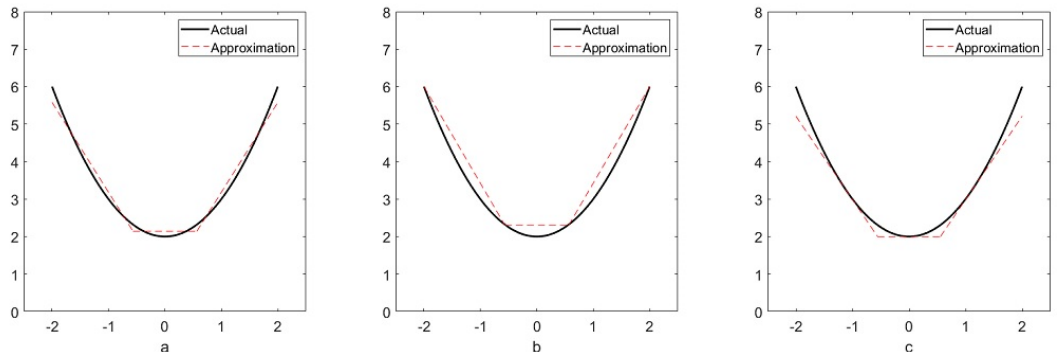
Figure 6. ( a ) Example of approximation produced when curve cross-over is allowed; ( b ) Example of approximation when restricted to entirely above the curve; ( c ) Example of approximation when restricted to entirely below the